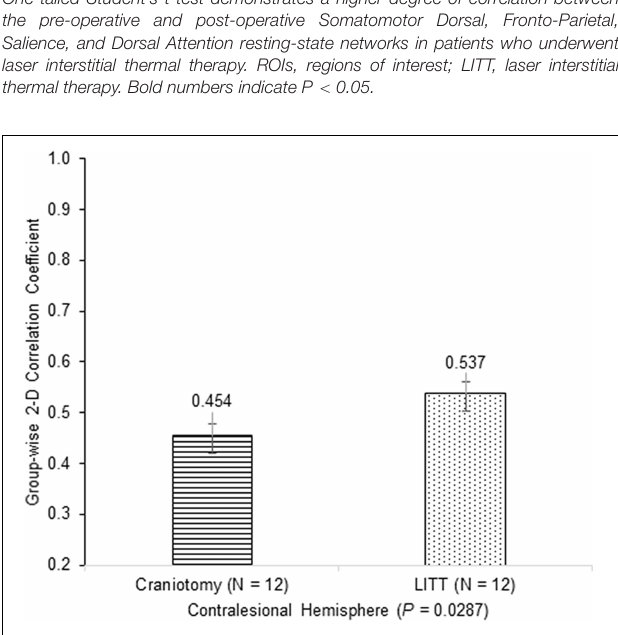
FIGURE 5 | Group-wise 2-dimensional correlation coefficients between pre-operative and post-operative hemispheres between patients who underwent craniotomy and LITT (laser interstitial thermal therapy). There was a greater degree of correlation in patients who underwent LITT (one-tailed Student’s t -test, assuming unequal